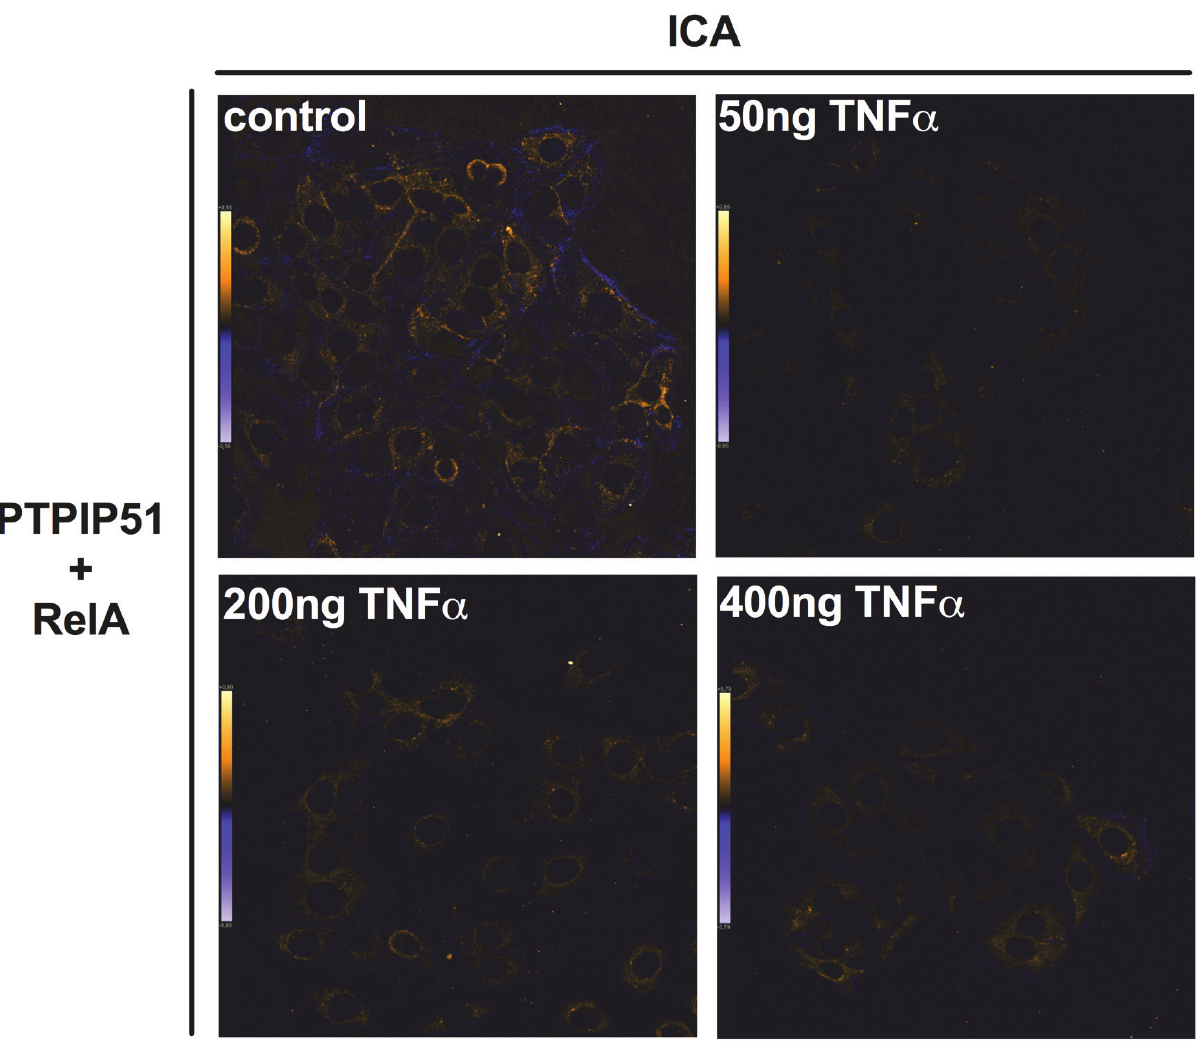
Figure 4. Intensity correlation (ICA) of PTPIP51 and RelA. ICA was determined for PTPIP51 and RelA in untreated controls, 100 ng/mL TNF(cid:3) treated cells, 200 ng/mL TNF(cid:3) treated cells, 400 ng/mL TNF(cid:3) treated cells. The co-localization of PTPIP51 and RelA is displayed in orange. Sites of non-co-localization are marked in